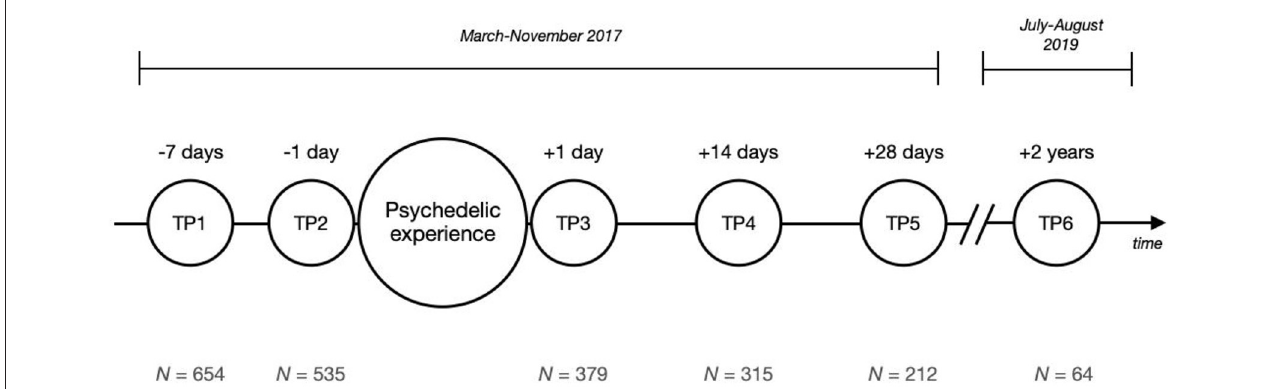
FIGURE 1 | Survey study timeline. The small circles represent the six time points (TP) of measurement. Above each circle the time in reference to the psychedelic experience is shown; below each circle the corresponding sample size ( N